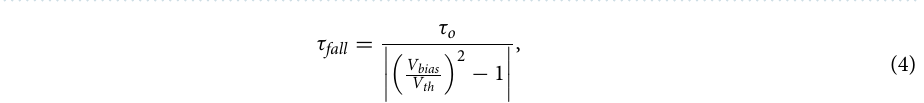
Figure 4. Time-dependent intensities of spots at focal planes when the HLC lenses are turned ( a ) on and ( b ) off; schema of ( c ) SPEFs on the HLC